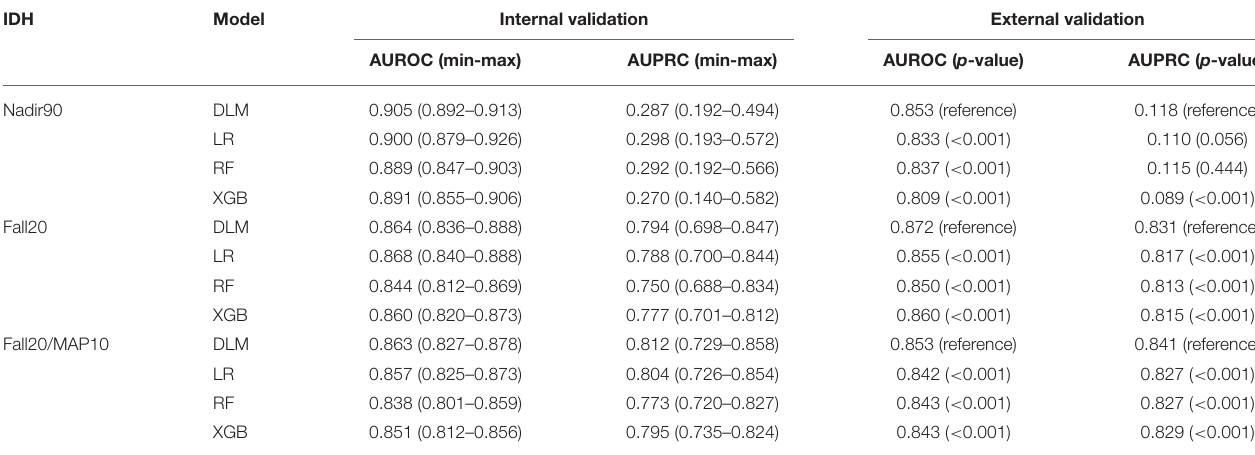
TABLE 3 | Model performance for predicting intradialytic